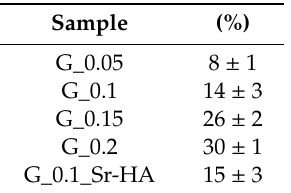
Table 2. Extent of crosslinking (%) 1 .